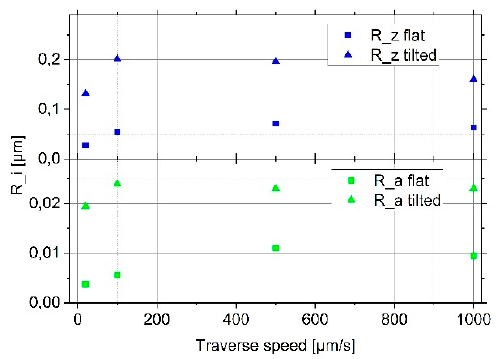
Figure 7. Measured roughness parameters for four different traverse speeds on a well-aligned optical flat (square symbols) and on an optical flat inclined by 100- µ m to increase the probing force (triangle symbols) (Rz: blue and Ra: green). Table 1. Measured roughness parameters for a tilted optical flat (100 µ m) and for one that is not tilted for four different traverse speeds (standard deviation in parenthesis, λ c = 80 µ m and λ s = 2.5 µ m). Traverse